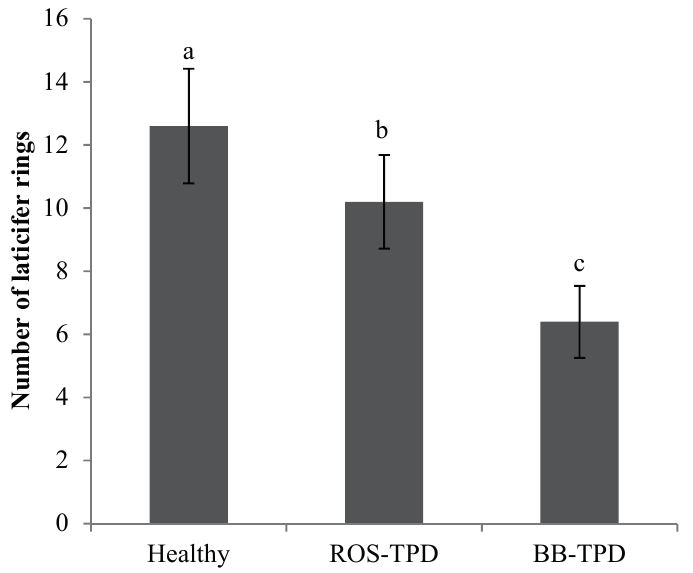
Figure 8. Number of laticifer rings in healthy, Tapping Panel Dryness (TPD)-affected trees, and brown bast (BB)-TPD-affected trees for high latex metabolism clone PB 260. The